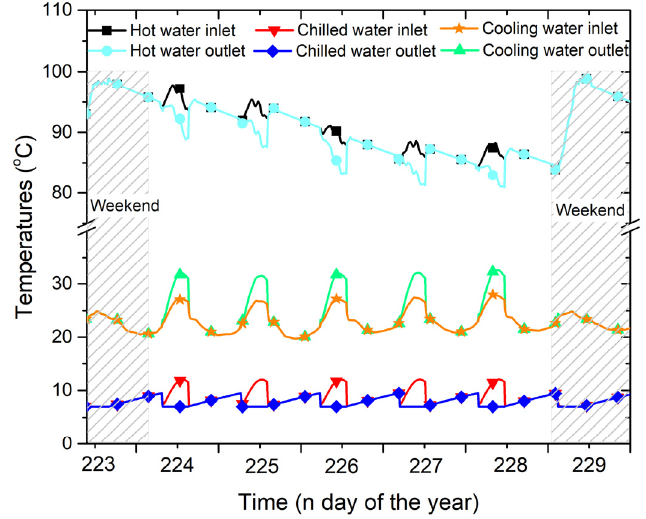
Figure 6. Variation in system circuit temperatures.